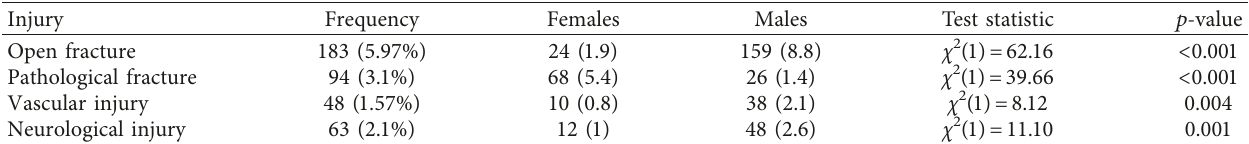
Table 3: Fracture-associated injuries at the time of presentation, n �